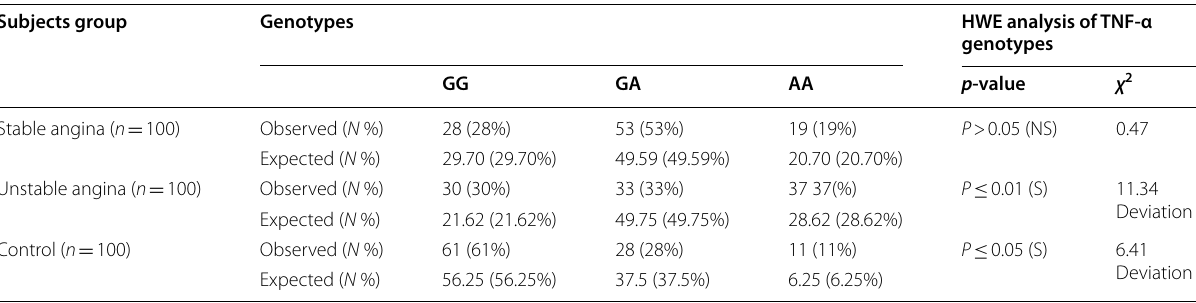
Table 2 Genotype and percentage frequency of TNF-alpha polymorphism (rs1800629)-308 G/A and their Hardy–Weinberg equilibrium (HWE) of the studied groups